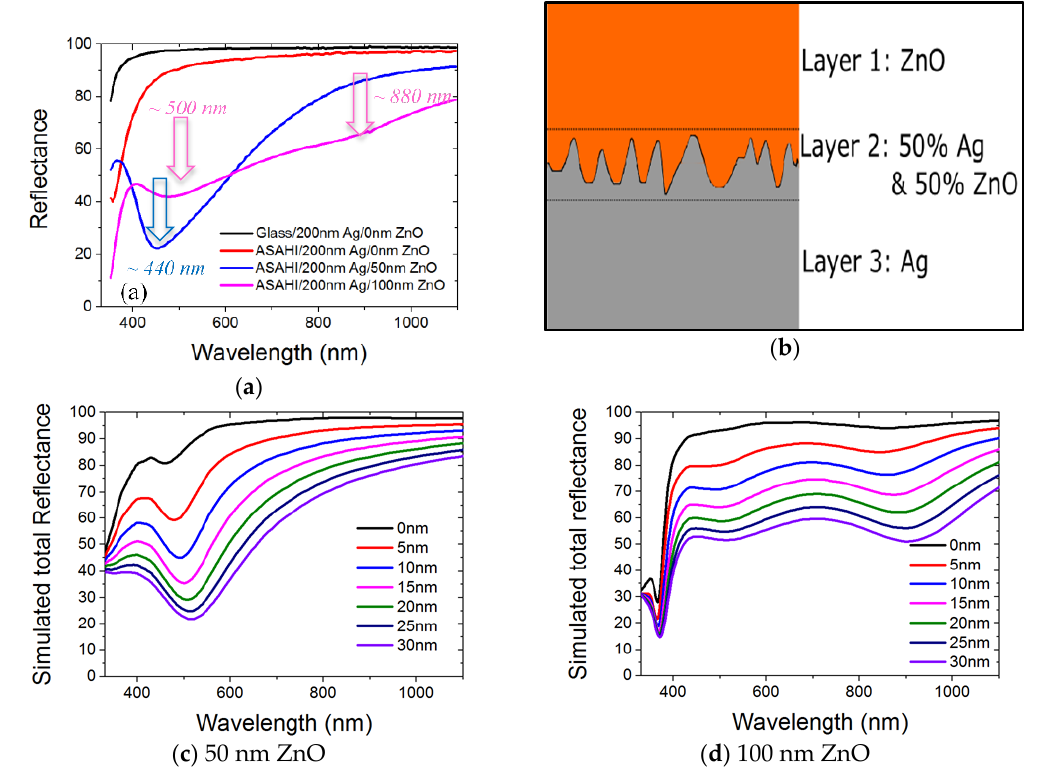
Figure 4. ( a ) Total reflectance measured on ASAHI substrate coated with 200 nm Ag and with 0, 50, and 100 nm of ZnO; ( b ) Bruggeman effective medium approximation model applied for the Ag/ZnO back reflector (BR) study; ( c ) and ( d ) Simulated total reflectance of 50 and 100 nm ZnO (layer 1) with 0 to 30 nm of Ag/ZnO interface (layer 2) thickness.